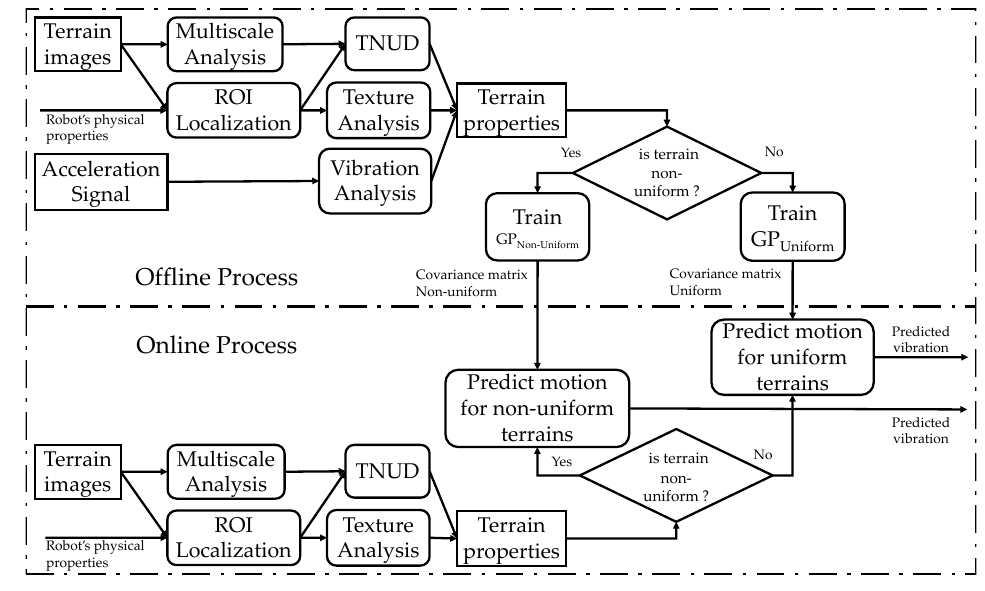
Figure 5. Overview of the proposed traversability cost